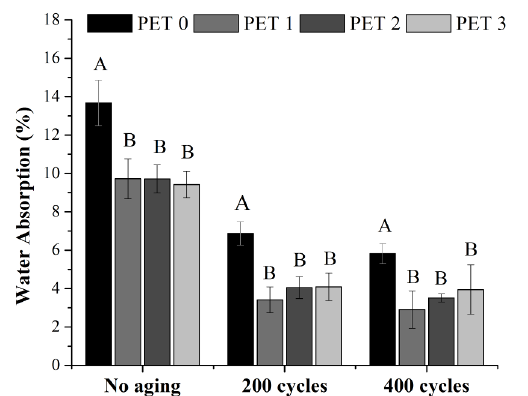
Figure 2. Average and standard deviation values of water absorption of fiber cement produced with PET particles. Consecutive means of the same letter do not statistically differ by the Scott-Knott mean test, at 5% of significance. PET1= 20 to 24 mesh, PET2= 24 to 32 mesh and PET3 = 32 to 35